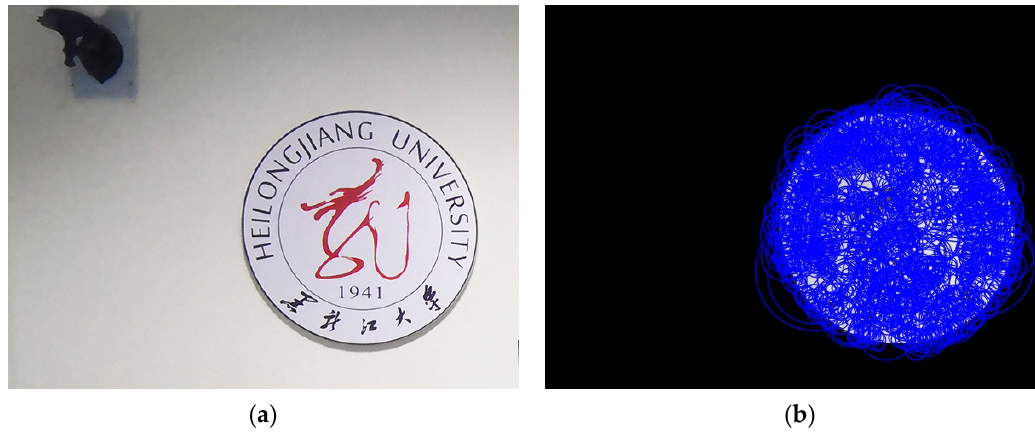
Figure 10. Foreground feature extraction based on ARAC. The feature points extracted from the foreground area are represented by blue circles: ( a ) origin image; ( b ) ARAC foreground feature.